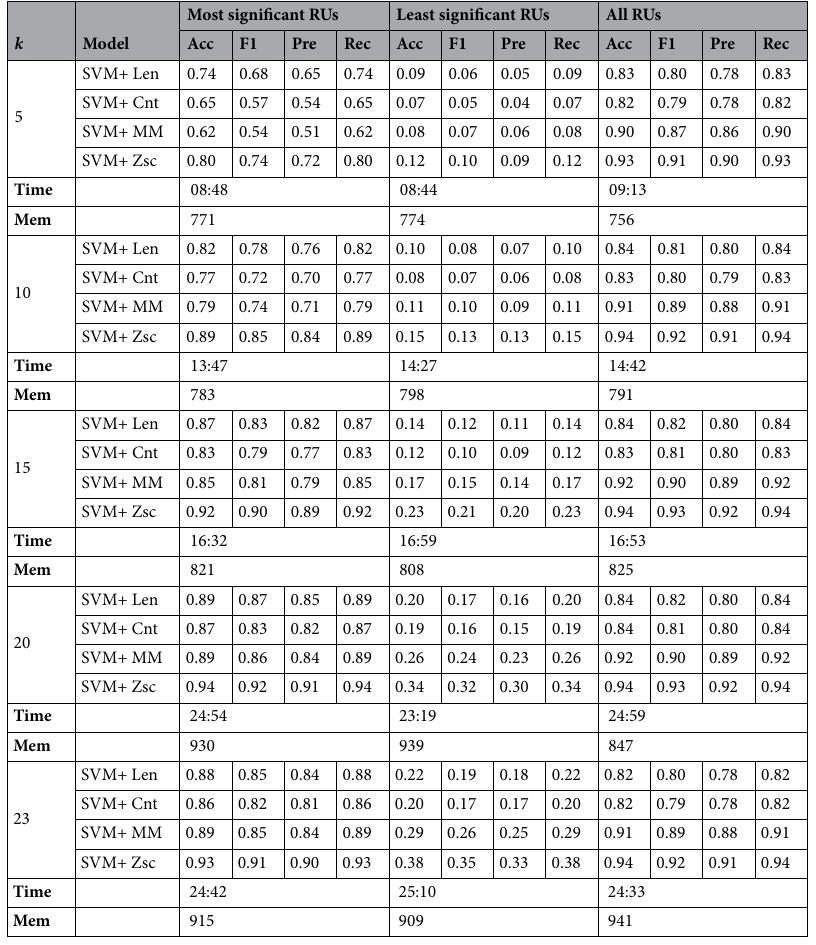
Table 4. Effect of varying the top k features on HUM test sets. Accuracy indicated by Acc, F1-score indicated by F1, Precision indicated by Pre, and Recall indicated by Rec. Also, the time is reported in the format mm:ss while the peak memory usage is in